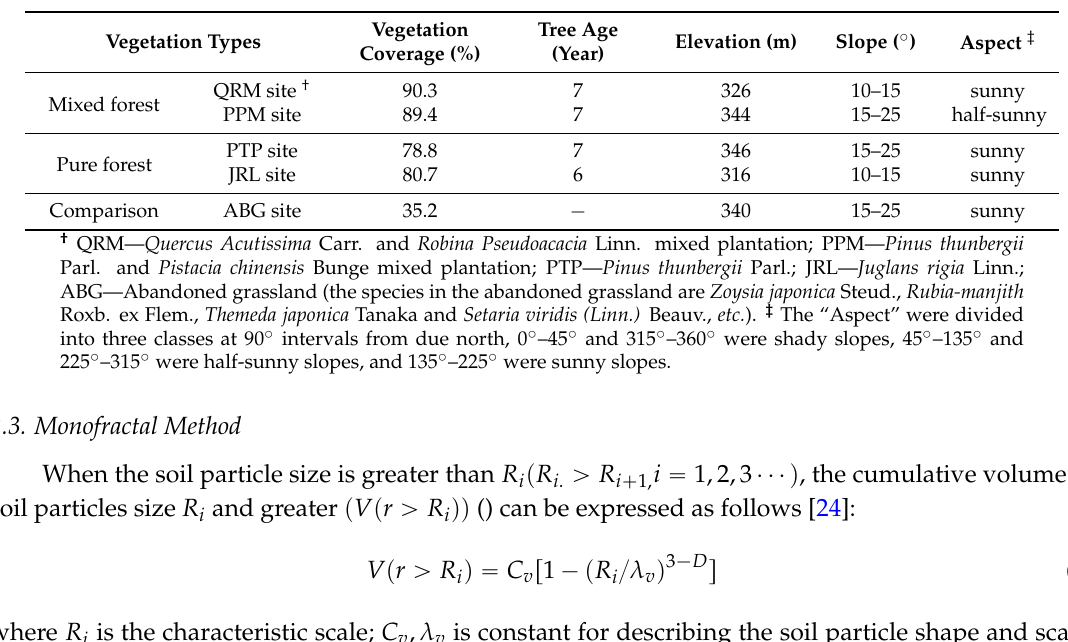
Table 1. Basic situation of the sampling standards in the study